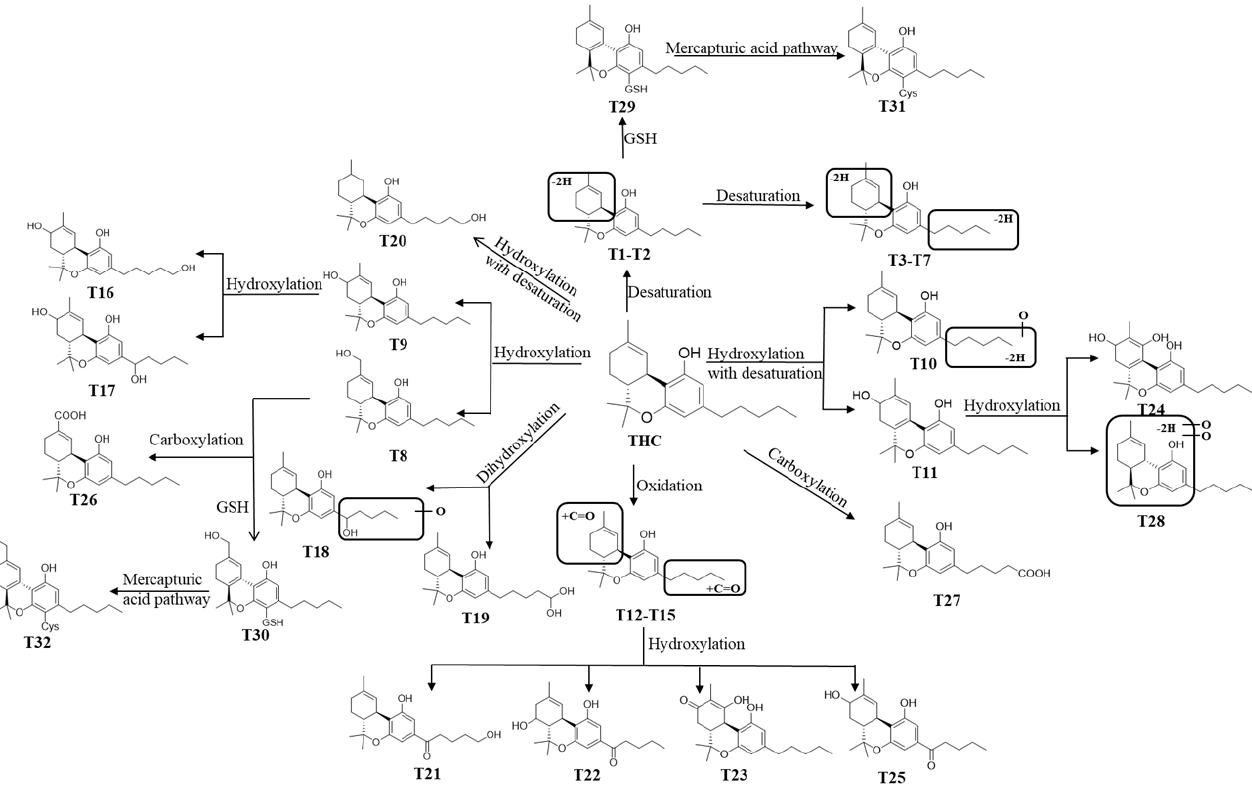
Figure 7. Proposed metabolic pathways of